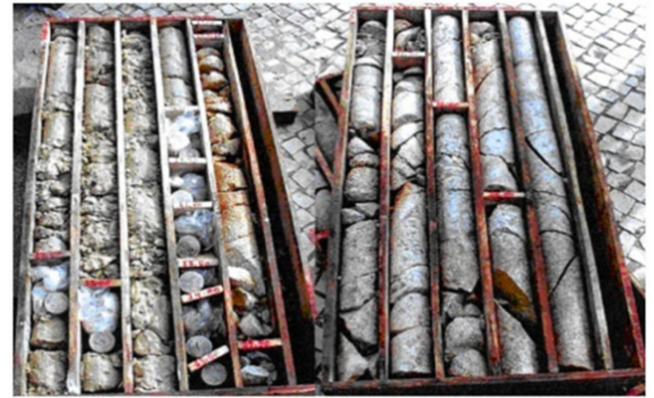
Figure 3. Geological sampling results of the